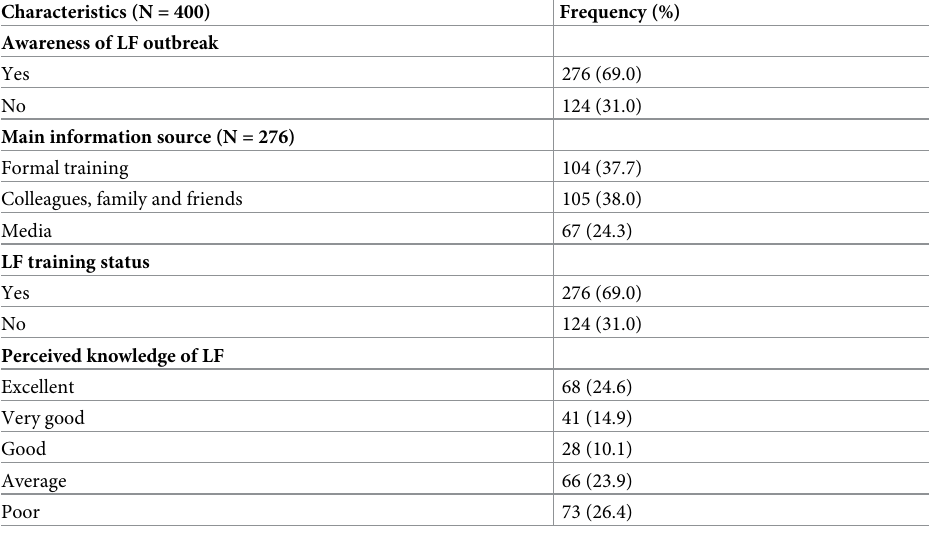
Table 2. Awareness, perceived knowledge and training on Lassa fever among healthcare